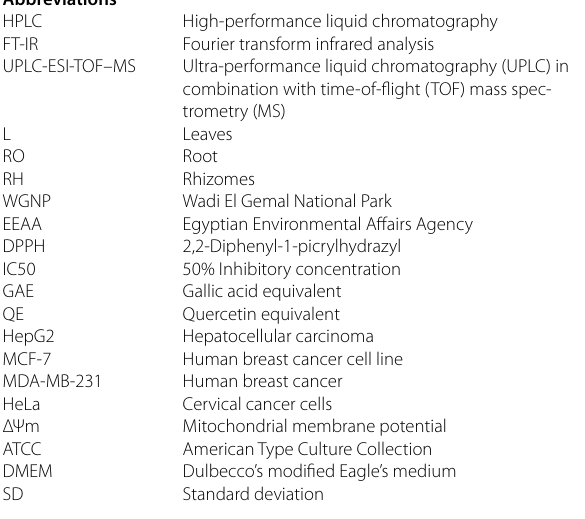
Additional file 1 . Figure S1 : HPLC chromatogram of Enhalus acoroides (L.f.) Royle leaves. Figure S2 : HPLC chromatogram of Enhalus acoroides (L.f.) Royle rhizome. Figure S3 : HPLC chromatogram of Enhalus acoroides (L.f.) Royle root. Figure S4 : HPLC chromatogram of standard samples for: (1) Gallic acid (RT 4.2 min), (2) Protocathechuic acid (RT 6.7 min) (3) p-hydroxybenzoic acid (RT 10 min) (4) Syringic acid (RT 14.7), (5) Vanillic